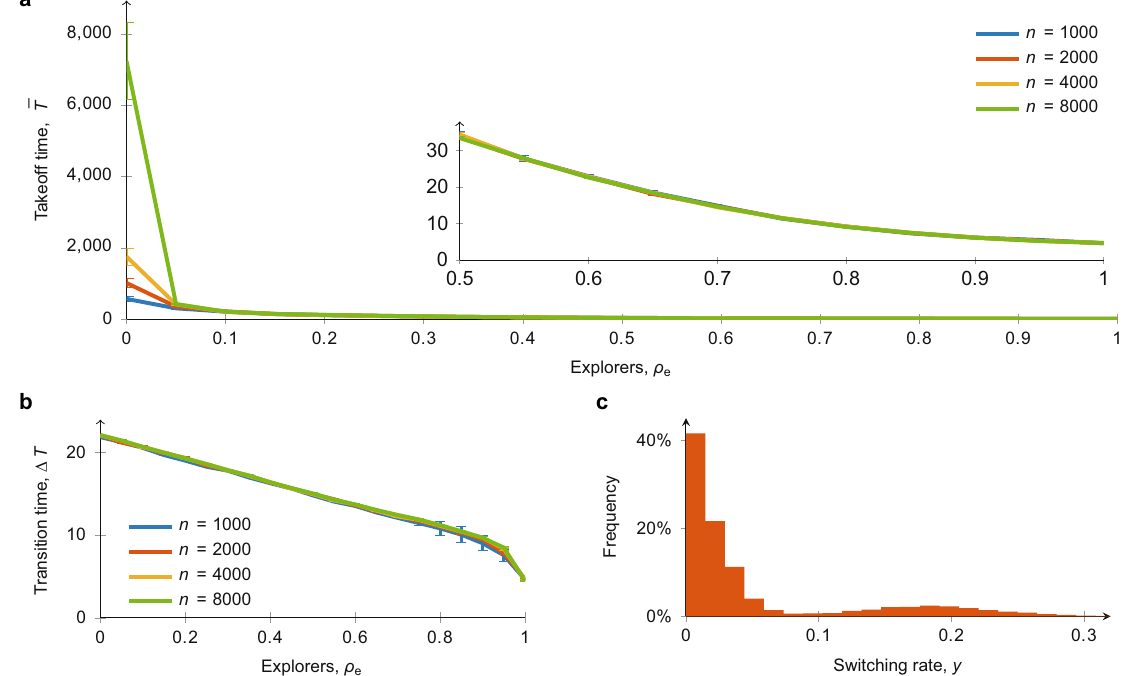
Fig. 4 Monte Carlo estimation of the take-off time, the transition time, and the switching rate of regular agents. Estimations are performed over 200 independent simulations. a Take-off times ( (cid:2) T ) estimated for different fractions of explorers and increasing population sizes, with a fi xed 25% committed minority. Vertical bars are 95% con fi dence intervals. b Transition times ( Δ T ) estimated for different fractions of explorers and increasing population sizes, with a fi xed 25% committed minority. Vertical bars are 95% con fi dence intervals. c Switching rate ( y ) estimated for n = 1000 and ρ e =